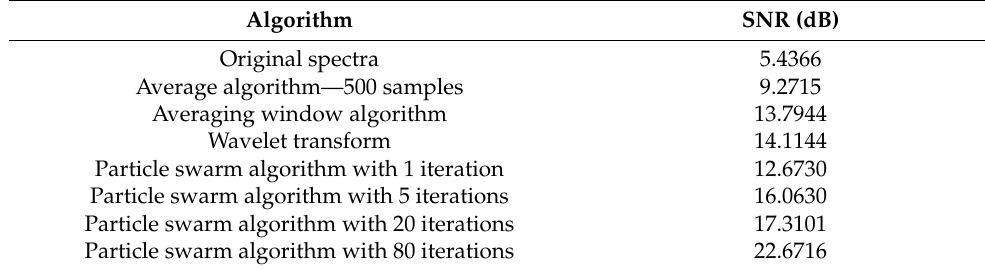
Table 1. The SNR of different algorithms.